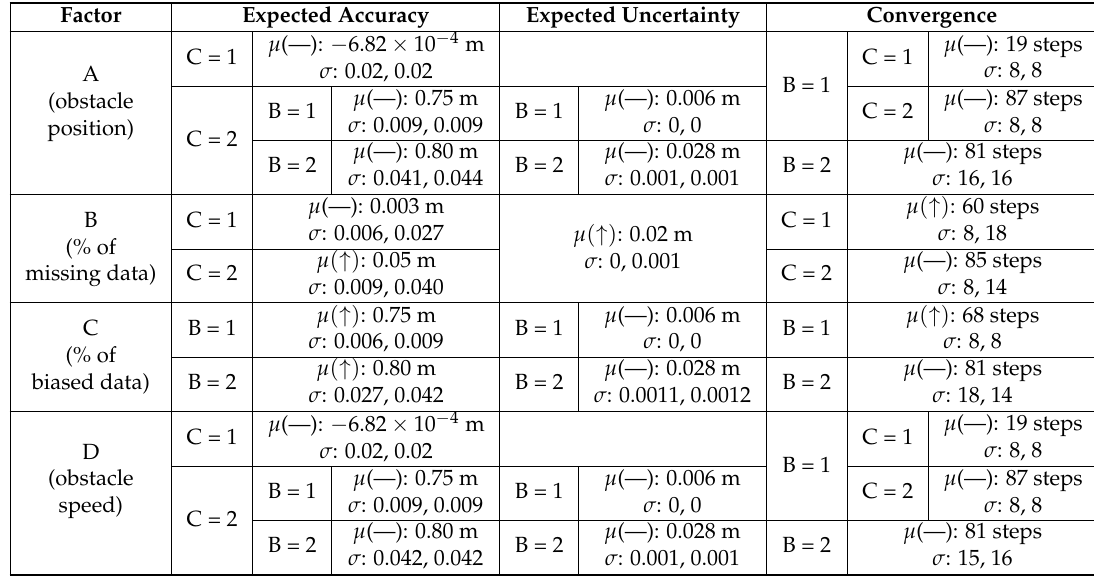
Table 4. Summary of the conclusions obtained for the effect that each factor has on the performances of the filter. Again, “1” and “2” stand for the low and high levels of the factors, respectively. See Table 2 for the numerical values of the factors. Here, µ and σ represent the mean and standard deviation of the factor. The symbol “—” denotes no effect on the mean, which is indicated along with its value, and “ ↑ ” represents an increase in that value, which is accompanied in this case by the difference between means at each extreme (the high one minus the low one). In each cell, the extreme values of the standard deviation are also